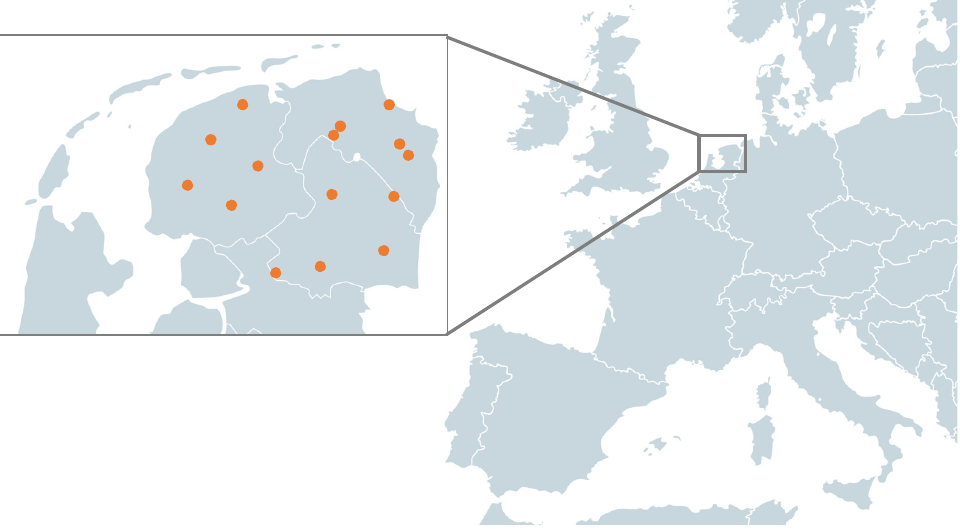
Figure 1. Locations of the fifteen hospitals in the three provinces in the North of the Netherlands. Between 2013 and June 2018, the region comprised fourteen hospitals; in July 2018, two hospitals merged into one new hospital, leaving a total of thirteen currently active hospitals.